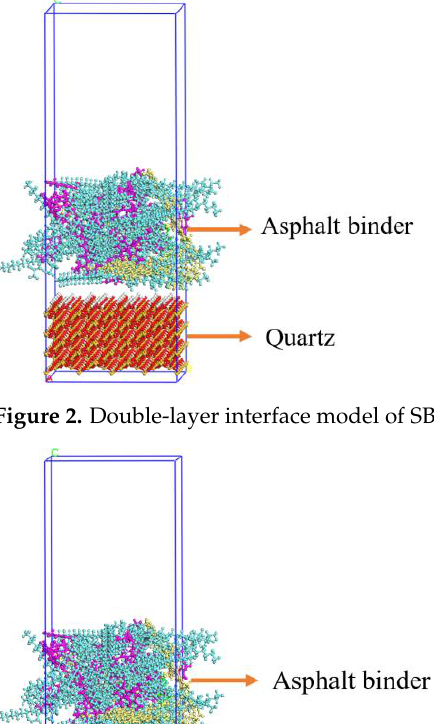
Figure 2. Double-layer interface model of SBS modified asphalt binder – aggregate.